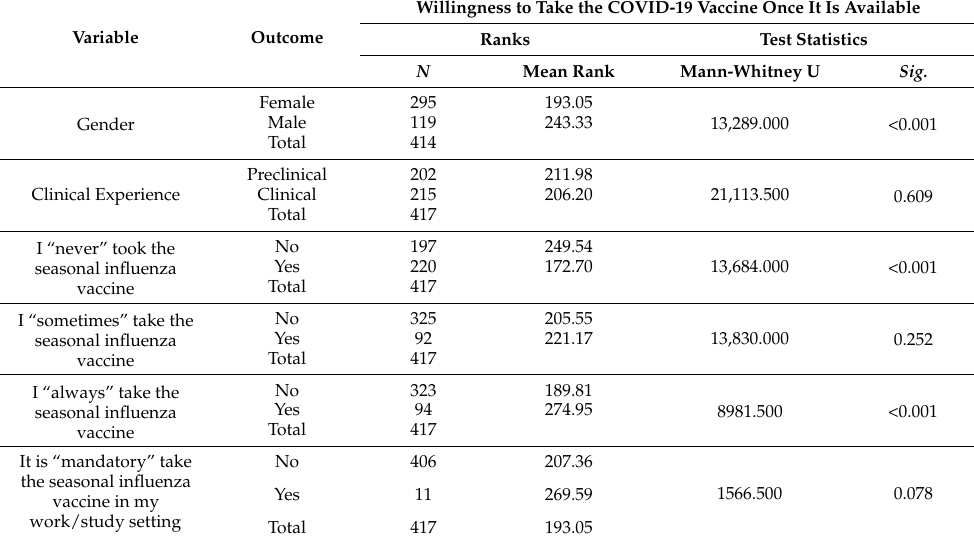
Table 7. Predictors of Palestinian dental students’ willingness to receive COVID-19 Vaccine, February—March 2021 ( n = 417).